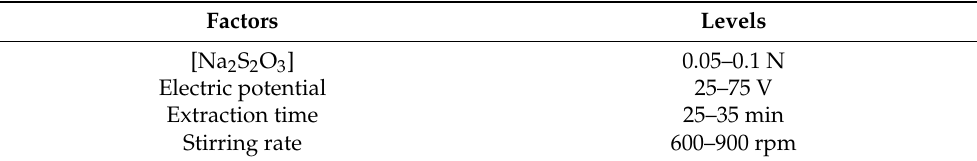
Table 3. Levels of the factors for the Draper–Linn design.